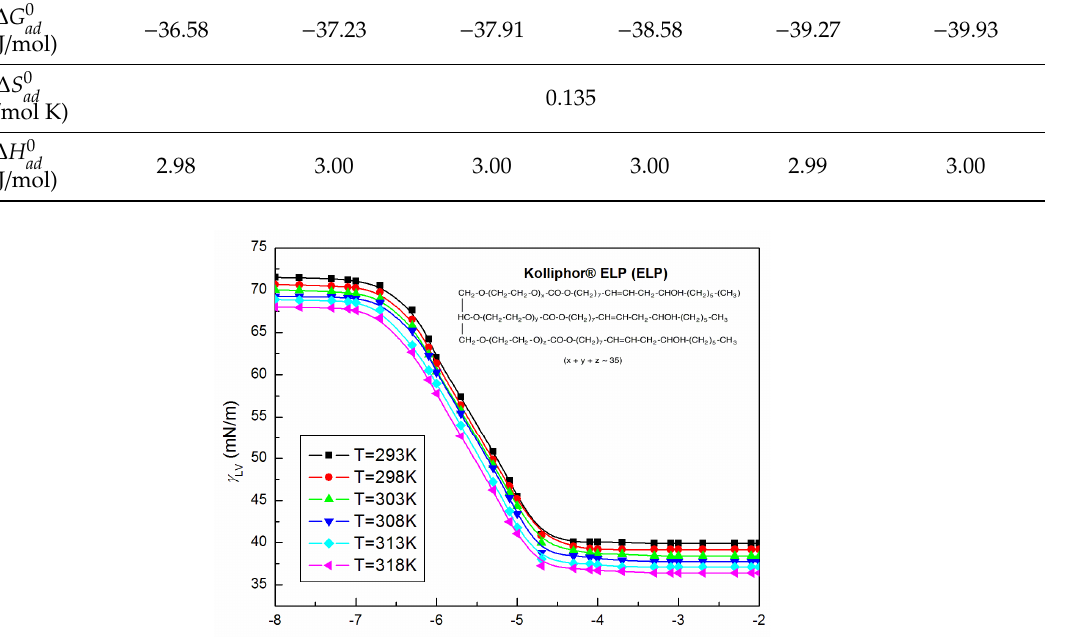
Figure 1. A plot of the values of the surface tension ( γ LV ) of the aqueous solution of Kolliphor ® ELP (ELP) at T = 293 K, 298 K, 303 K, 308 K, 313 K and 318 K vs. the logarithm of the surfactant concentration, log C .